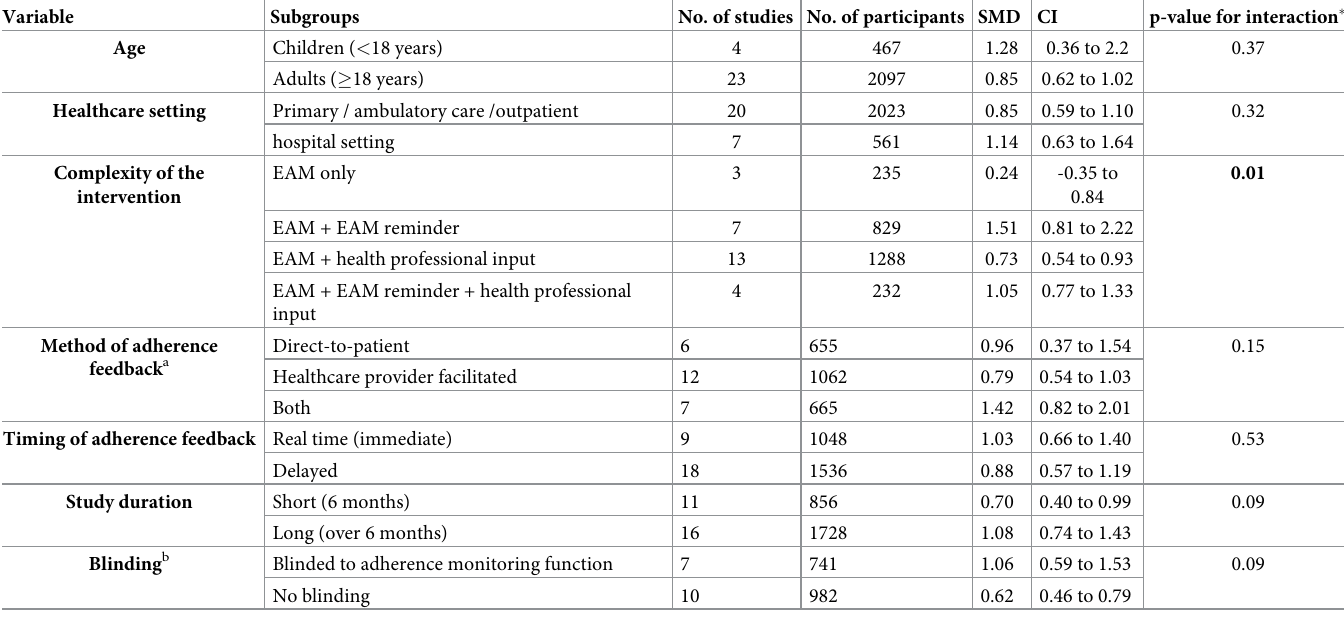
Table 2. Effect of study-level characteristics on medication adherence (n =